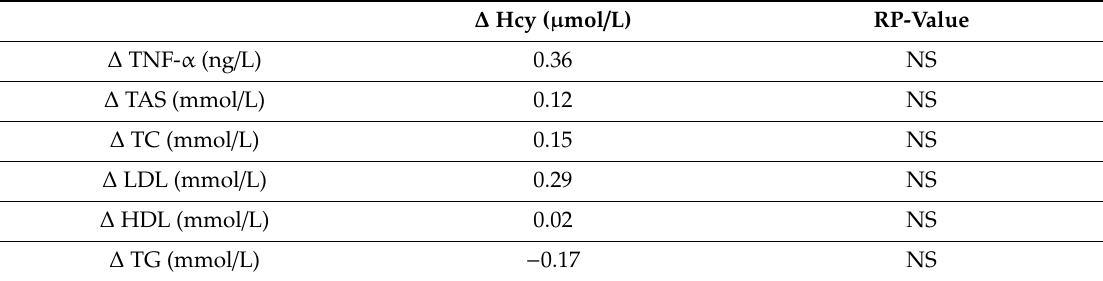
(Table 4). The multiple linear regression analysis showed that the change in Hcy was not associated with the changes in lipid profile, TNF- α and TAS levels in the probiotic group (Table 5). Table 4. Correlation analysis in the probiotic group between the change ( ∆ ) in Hcy concentration and the change ( ∆ ) in TC, LDL, HDL-cholesterol, TG, TNF- α and TAS level.